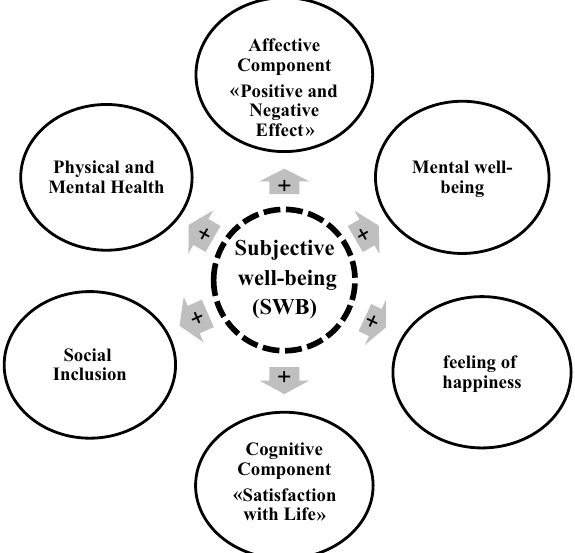
Figure 1. Main components of subjective well-being (SWB).